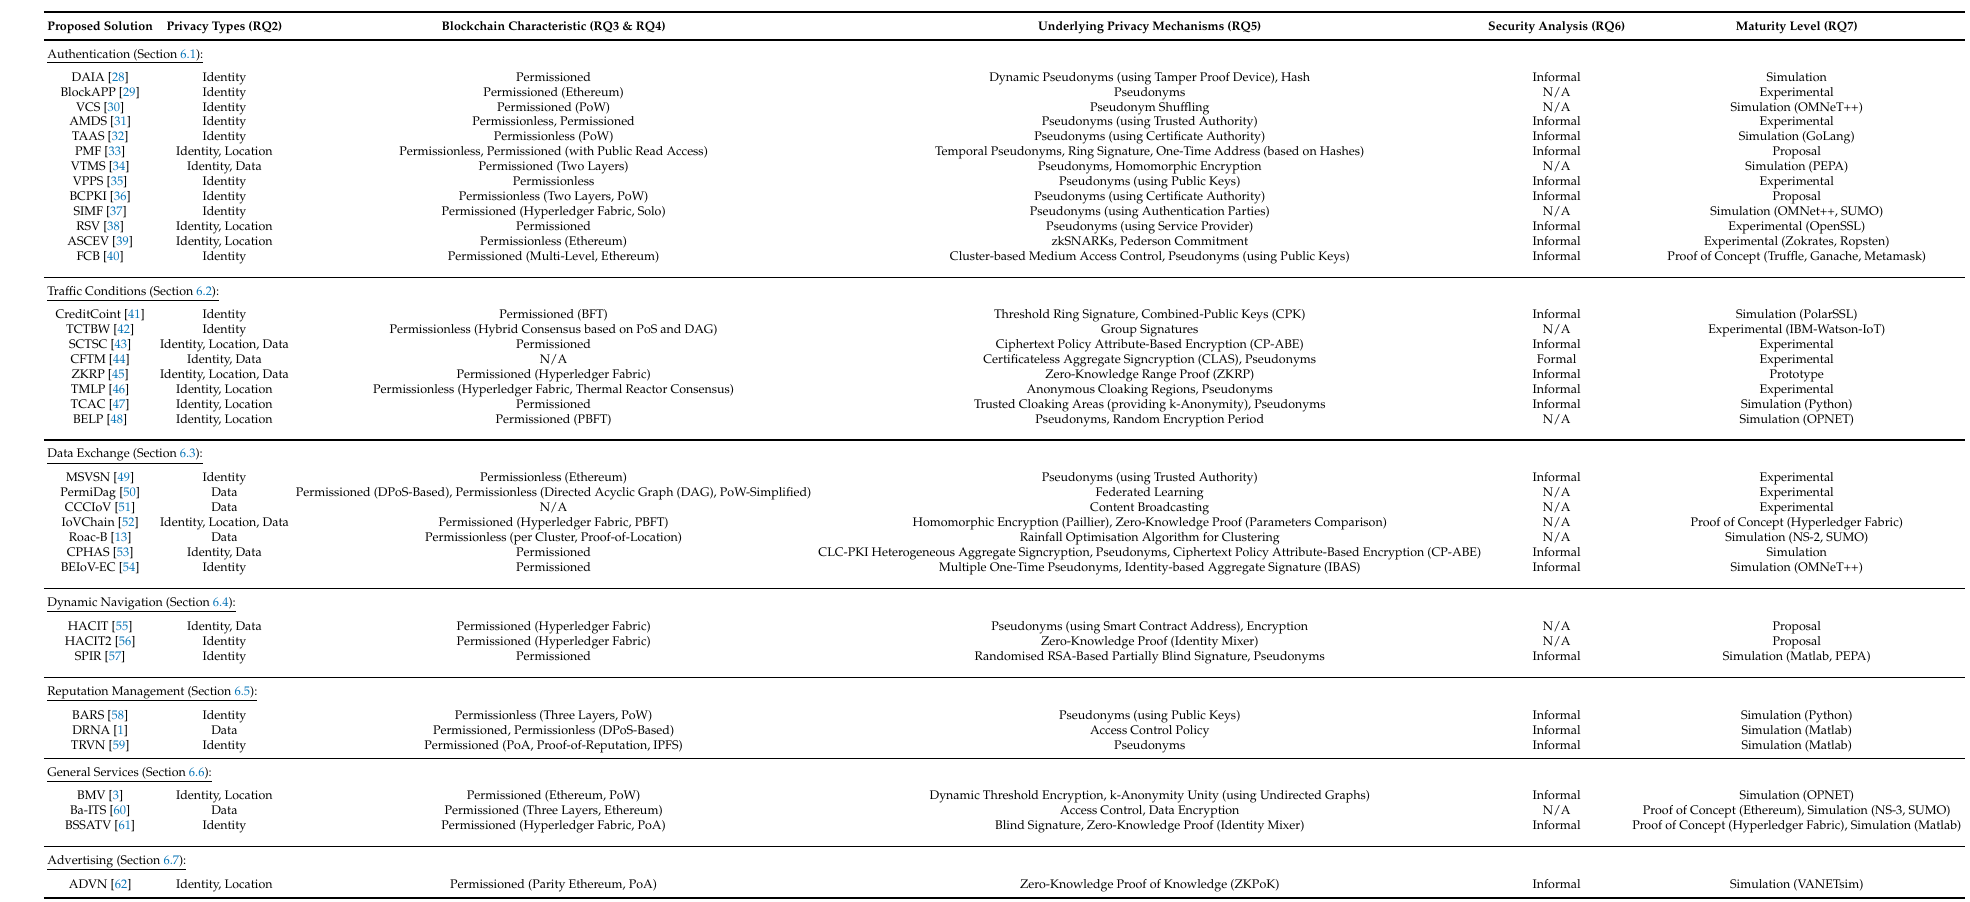
Table 1. Comparison of privacy-preserving blockchain-based solutions in the